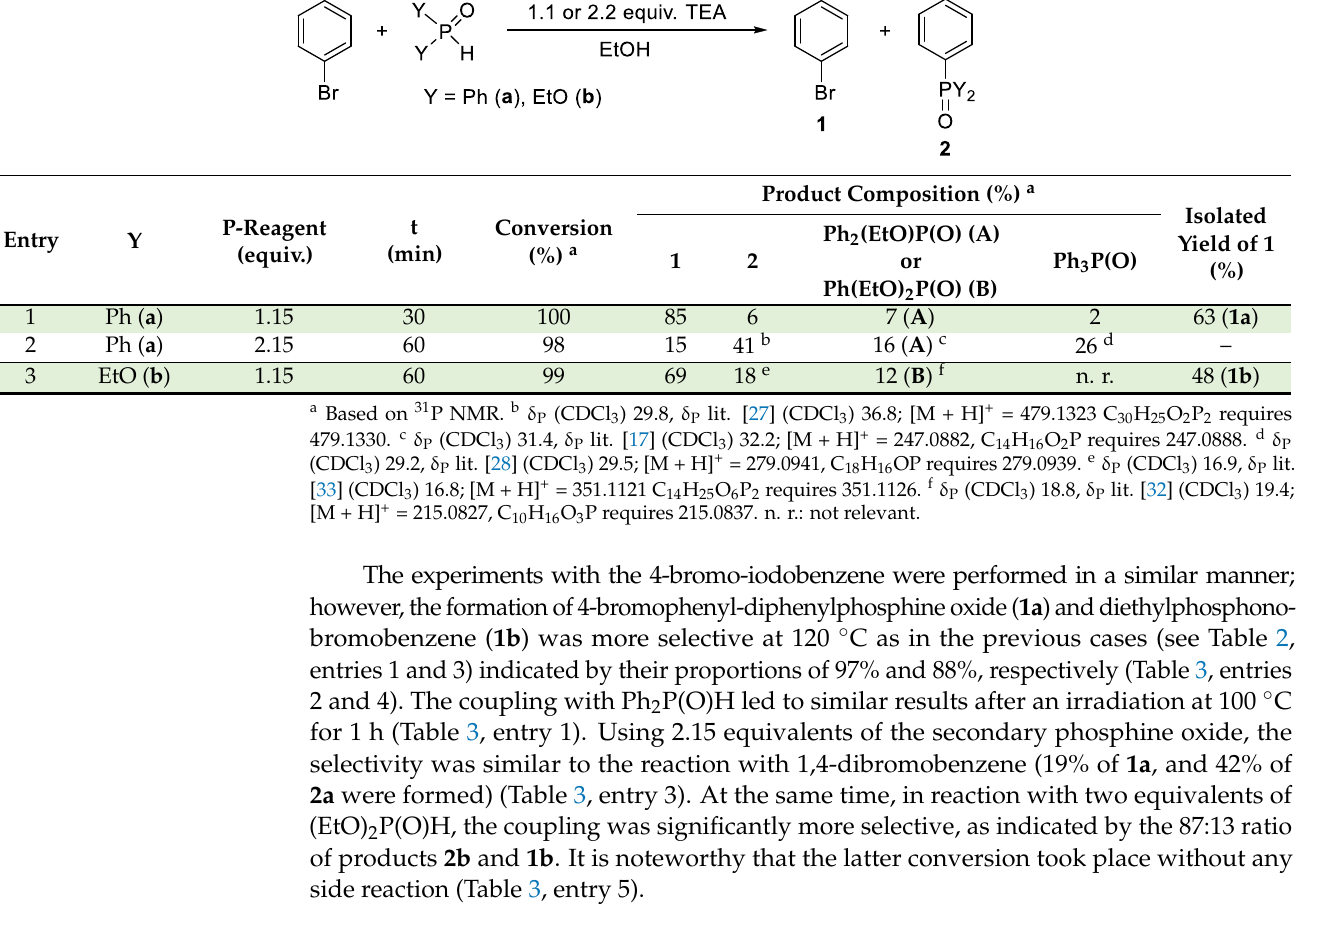
Table 3. P–C coupling reactions of 4-bromo-iodobenzene. Table 3. P – C coupling reactions of